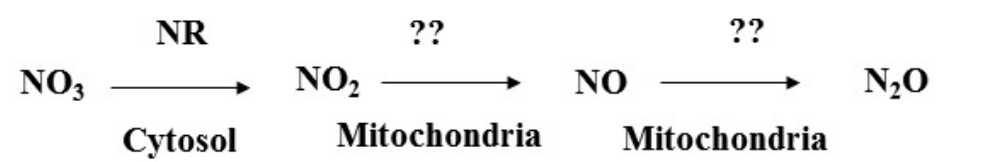
Figure 1. The potential pathway of N 2 O formation in rice plants under hypoxic conditions. ?? sign represents the involvement of two or more enzymes [9,23,27,44,48,52].